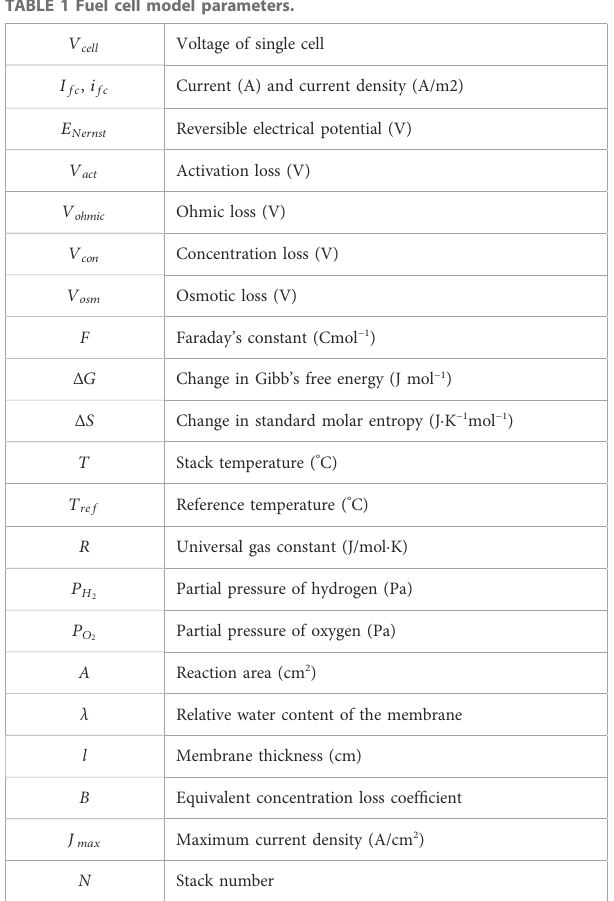
TABLE 1 Fuel cell model